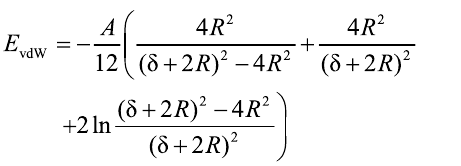
potential with a global minimum. In the example, the particles will assemble at a distance of about δ = 3.6